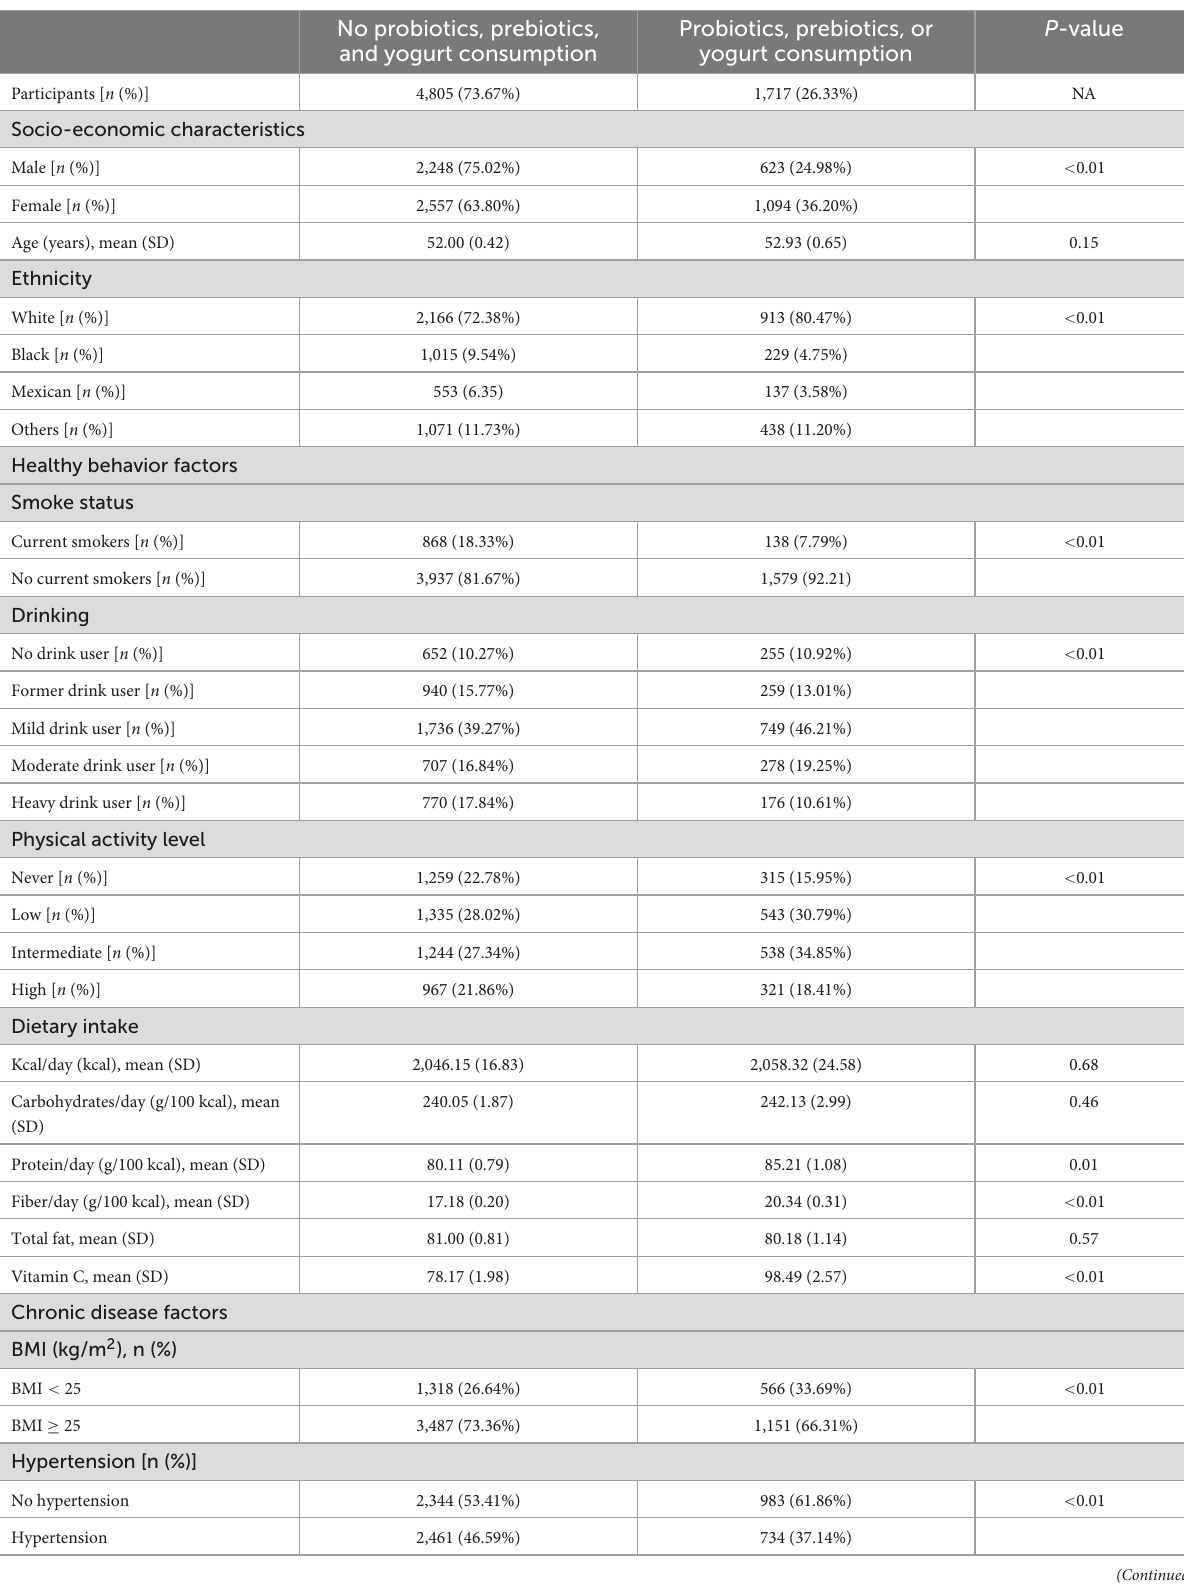
TABLE 1 Baseline population characteristics according to probiotic, prebiotic, and yogurt consumption in CKD patients ( n = 6522). No probiotics, prebiotics, Probiotics, prebiotics, or P and yogurt consumption yogurt consumption